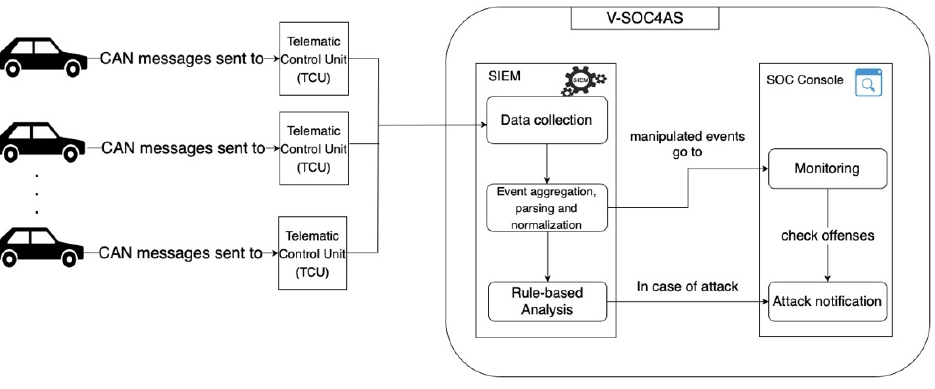
Figure 1. V-SOC4AS